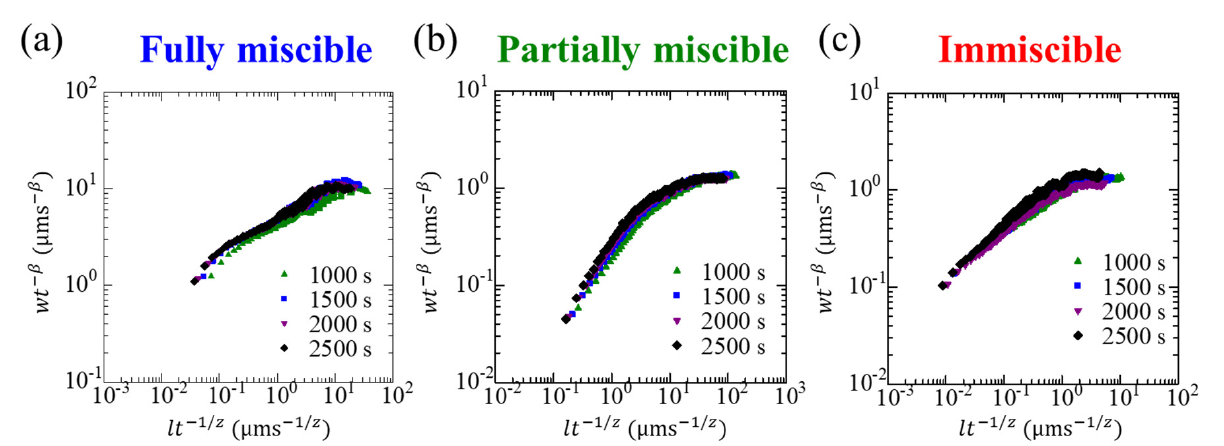
Figure 7. Collapse of data using Equation (1) for the ( a ) fully miscible, ( b ) partially miscible, and ( c ) immiscible systems presenting Family − Vicsek scaling.